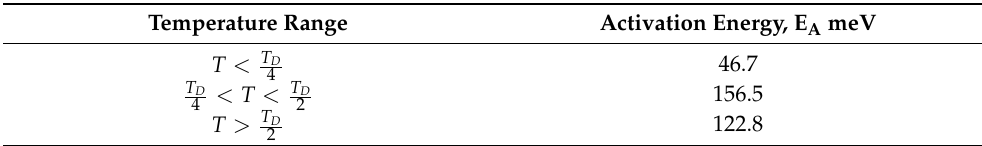
Table 3. Activation energies of SPH (Small Polaron Hopping) and VRH (Variable Range Hopping) mechanisms for La-CMFCNO.